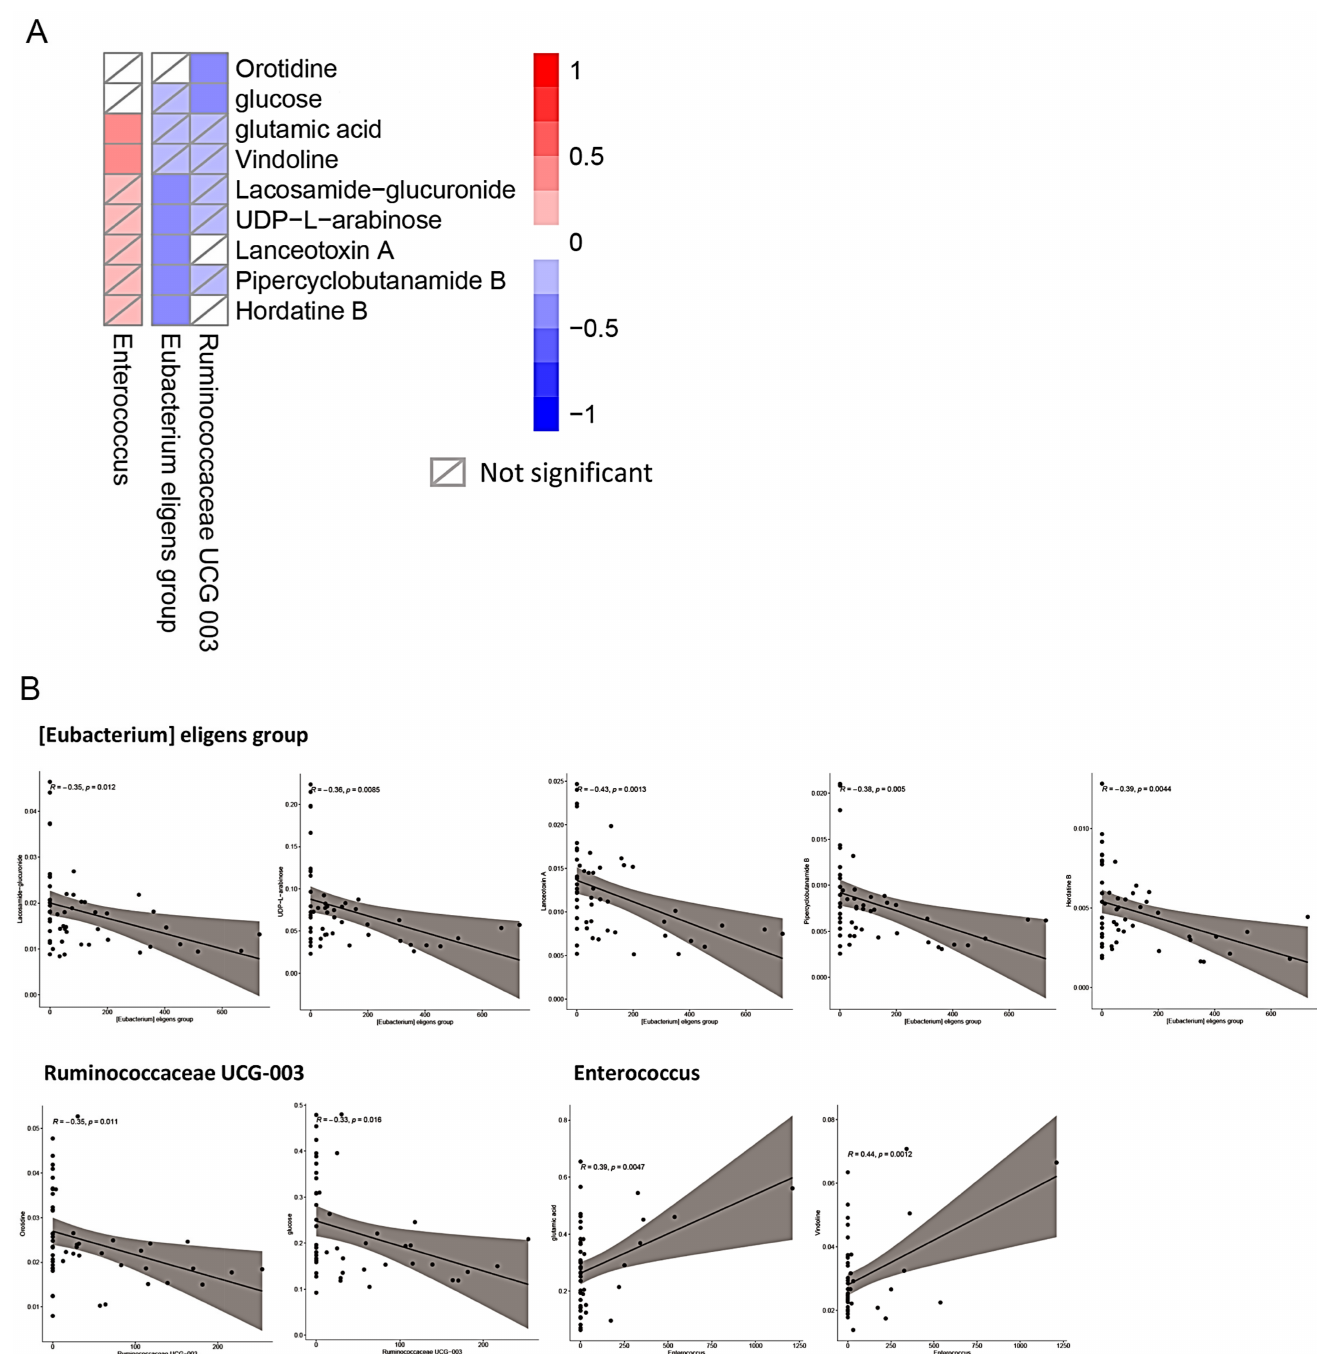
Figure 4. Association of changes between the gut microbiota and sera metabolites after metabolic surgery. ( A ) Correlation between the differential bacterial genus and the clinical indices-correlated metabolites. The correlation between 45 clinical indices-correlated metabolites and the 13 differential bacterial genera were analyzed, and the heat map of the Spearman’s rank correlation coefficient ( p < 0.02) are shown. ( B ) Scatterplots between the metabolites and bacterial genus. Scatterplot with a line of best fit illustrates the relationship between the metabolites and bacterial genus, which reveals a significant correlation in ( A